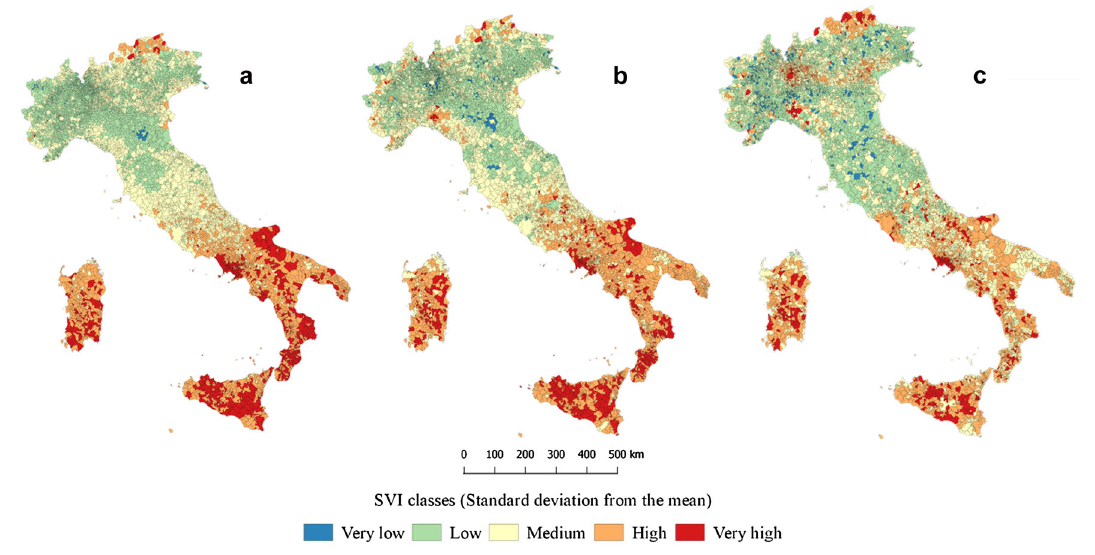
Fig. 3 Italy’s changing social vulnerability class spatial distribution: a 1991; b 2001; and c 2011. Very low (vulnerability \ - 1.5 SD); Low ( - 1.5 SD \ vulnerability \ - 0.5 SD); Medium ( - 0.5 Fig. 4 Percentage of Italian municipalities in the five classes of SVI for 1991, 2001, and